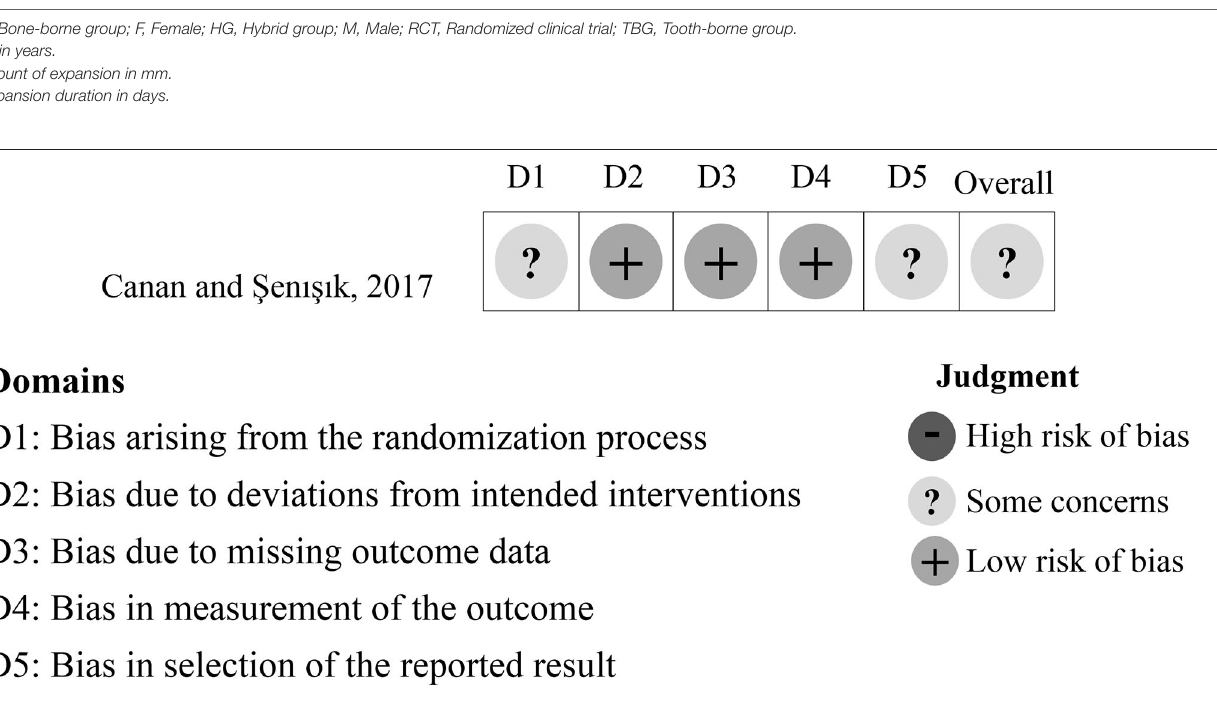
Canan and Seni¸sik; 2017 (36)